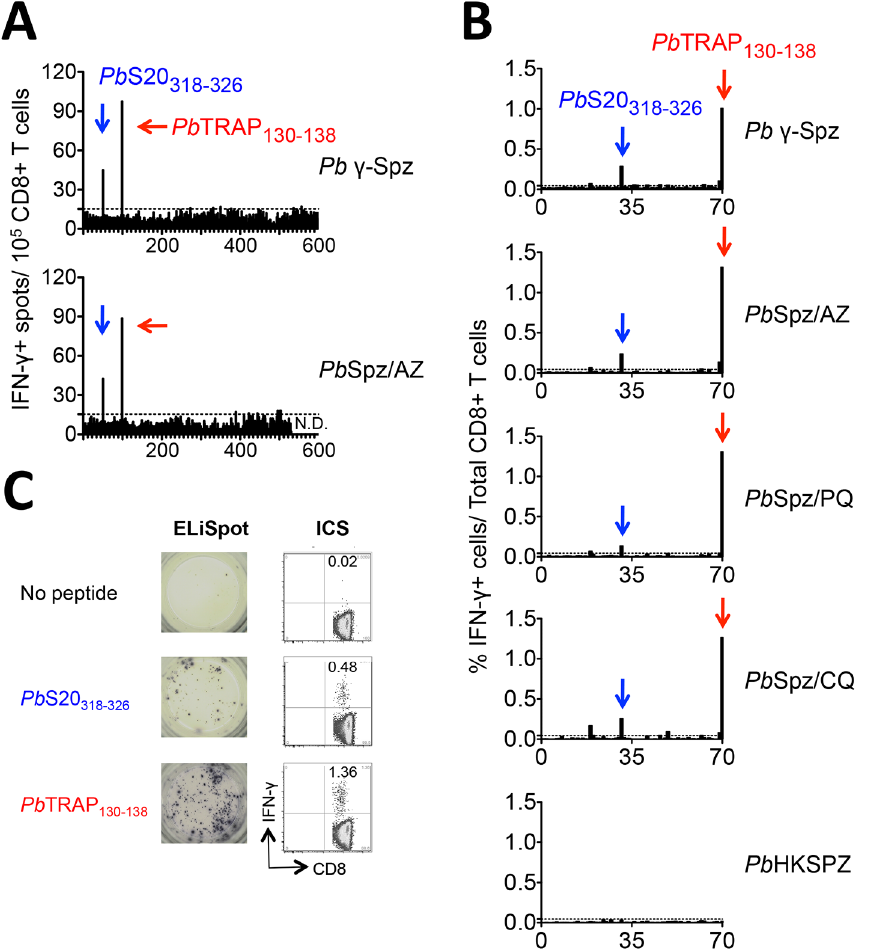
Figure 1. Systematic profiling of CD8 + T cell epitopes in sporozoite-immune B6 mice: Identification of Pb S20 318 ( Pb S20 318–325 ) and Pb TRAP 130 ( Pb TRAP 130–138 ) as targets of CD8 + T cell responses. ( A ) 600 peptides, which were predicted from Pb sequences to bind H-2 b molecules, were screened by ELISpot for their ability to induce IFN- c secretion in CD8 + T cells isolated and purified from mice immunised with Pb c - Spz (top) and Pb Spz/AZ (bottom). ( B ) The same peptides were used to stimulate spleen cells, and IFN- c secretion from CD8 + T cells was measured by ICS. Data shown is based on a sub-set of 70 peptides. From top: Spleen cells were isolated from mice immunised twice with Pb c -Spz, Pb Spz/AZ, Pb Spz/PQ, Pb Spz/CQ and Pb HKSpz. For (A) and (B), dotted lines represent cut-offs calculated using a mixture model. ( C ) Representative ELISpot wells (left) and ICS flow cytometry plots (right) of CD8 + T cells isolated from mice immunized twice with Pb c -Spz. Frequencies of IFN- c + cells/total CD8 + T cells are indicated.